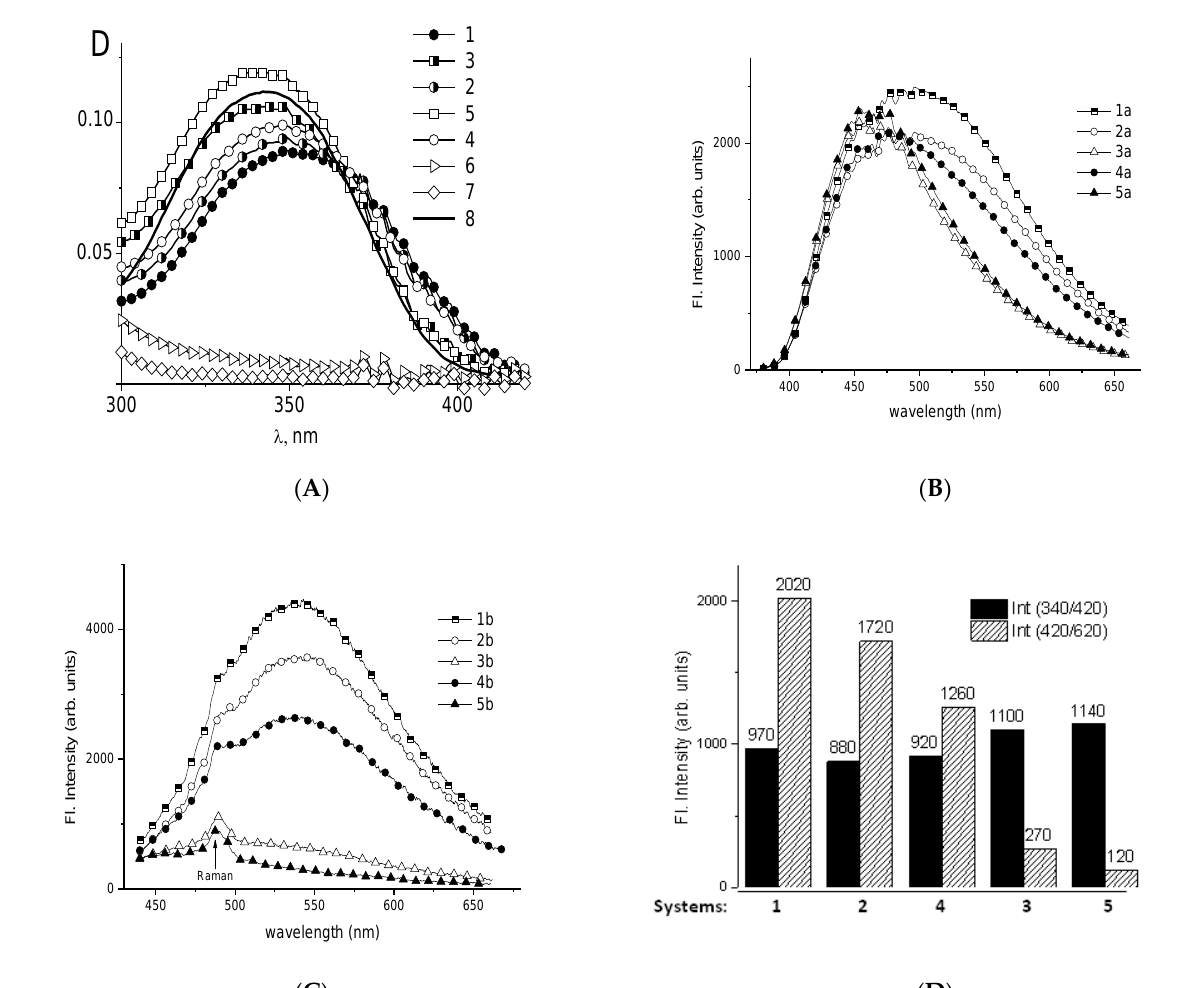
Figure 6. Absorption spectra ( A ) of DAPI in complexes with DNA in 0.005 M NaCl (1), DAPI in complexes with DNA after the addition of cis-DDP (2) and after the addition of Pt2 (3); after the addition of DAPI to the solution with DNA-cis-DDP (4) and with DNA- Pt2 (5) adducts; absorption of DNA- Pt2 (6), DNA-cis-DDP (7) and DAPI (8) solutions. C(DNA) = 1.5 × 10 −5 M, C(DAPI) = 5 × 10 −6 M, C(Pt) = 4 × 10 −5 M. Luminescence spectra ( B , C ) of DAPI in complexes with DNA in 0.005 M NaCl at λ ex = 340 nm (a) and λ ex =420 nm (b) for same systems. ( D ) Comparison of data presented in ( B ) and in ( C ): black bars —the strong binding of DAPI in DNA minor groove (λ ex = 340 nm, λ em = 420 nm); shaded bars — the electrostatic binding of DAPI with DNA phosphates (λ ex = 420 nm, λ em = 620 nm). Two different schemes were developed for the mixing of DNA, DAPI, and Pt2 solutions in 0.005 M NaCl: (1) DNA-DAPI complexes were formed, and Pt2 solution was added later; (2) the DAPI solution was added to the solution with DNA- Pt2 complexes (after one-day storage of DNA solution with Pt2 ). The measurements were performed one day after the second mixing. The concentrations of DNA, DAPI, and Pt2 were the same in all systems including the control DNA-DAPI and DNA- Pt2 solutions. Cis-DDP was used for comparison in a similar